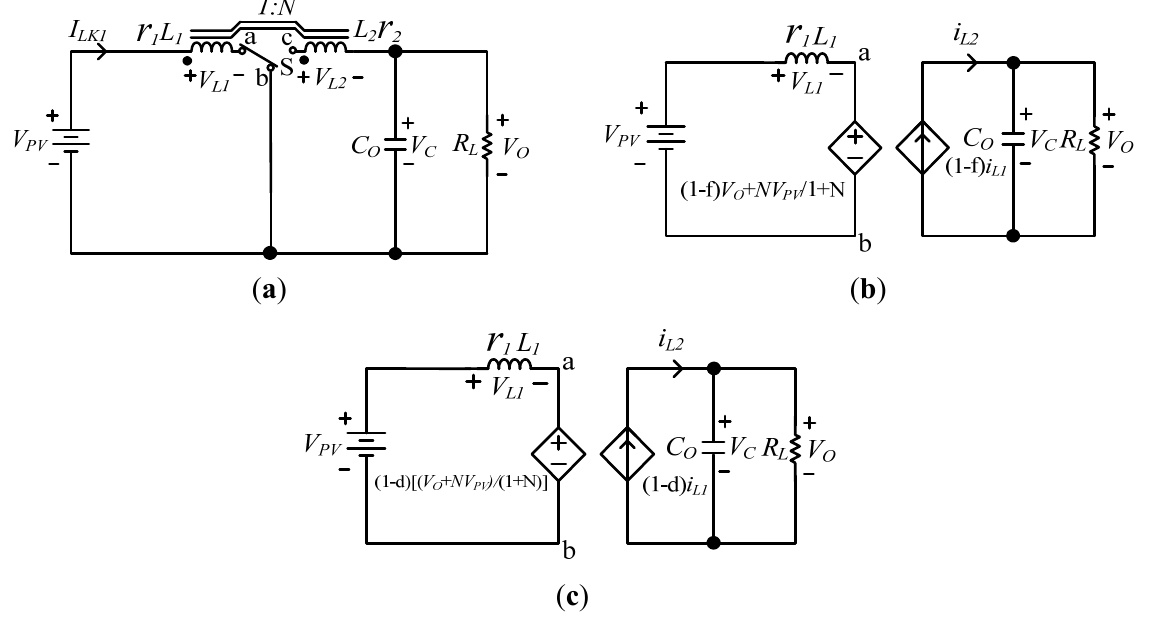
Figure 15. Equivalent circuit based on ( a ) ideal switch; ( b ) switching function; and ( c ) average equivalent circuit.